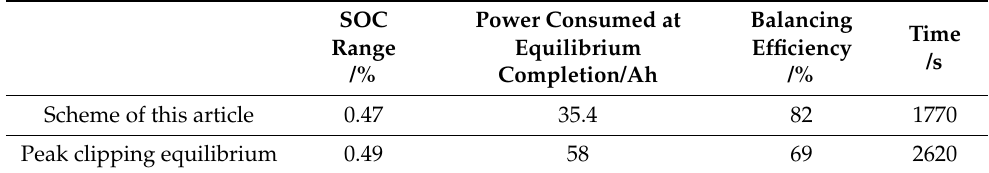
Table 6. Equilibrium result of static